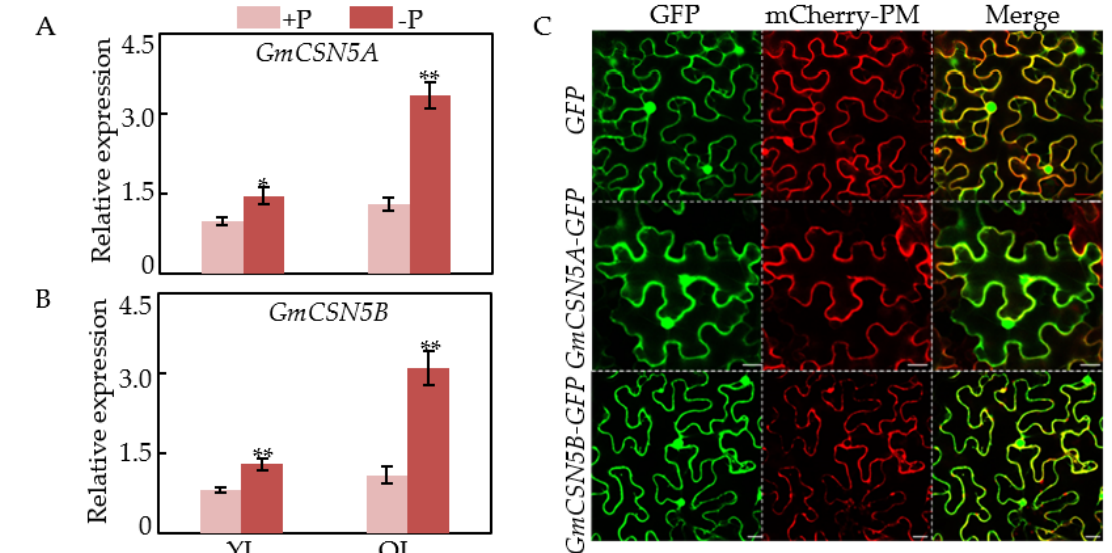
Figure 4. Expression patterns and subcellular localization of GmCSN5A/B . ( A ) Relative expression of GmCSN5A . ( B ) Relative expression of GmCSN5B . Data are mean of four replicates ± SE. Asterisks indicate significant difference between the two P levels in the Student’s t -test (* p < 0.05; ** p < 0.01). ( C ) Subcellular localization of GmCSN5A and GmCSN5B . mCherry-PM represents plasma membrane localization indicated by the red fluorescence derived from AtPIP2A-mCherry. Bars = 20 μ m.